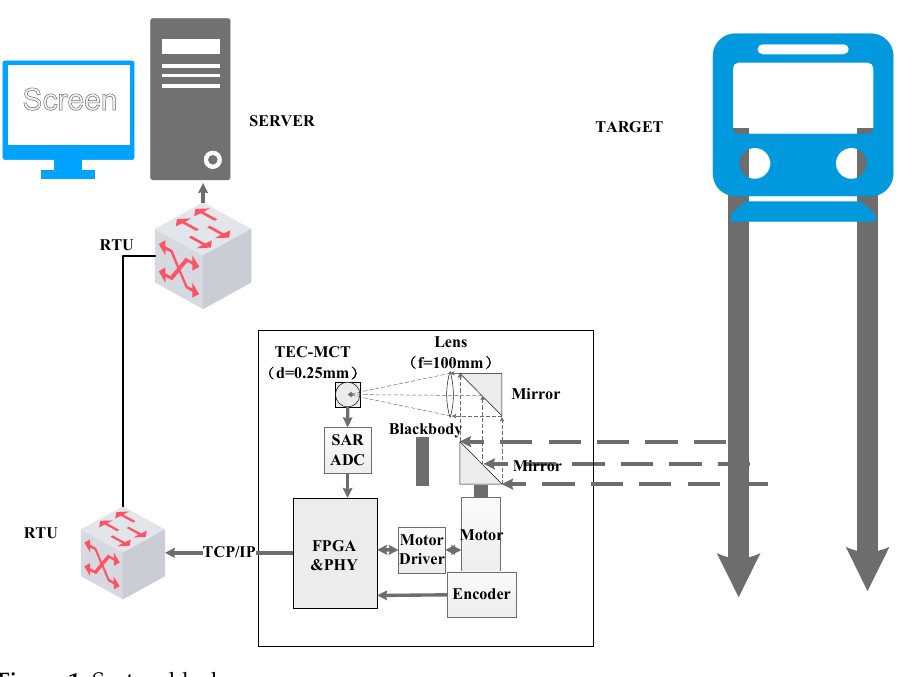
Figure 1. System block.